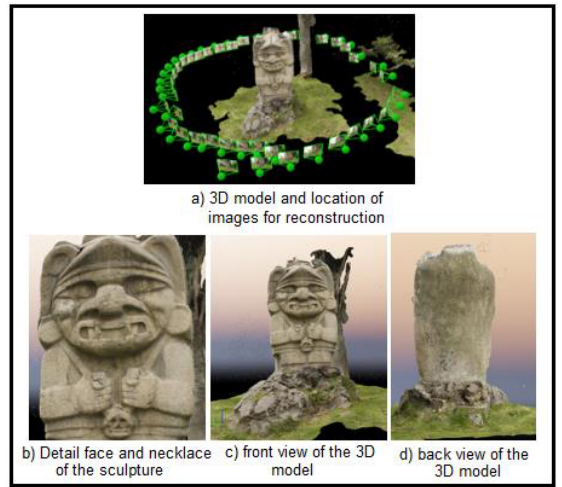
Figure 6. 3D Model replica sculpture San Agustín No